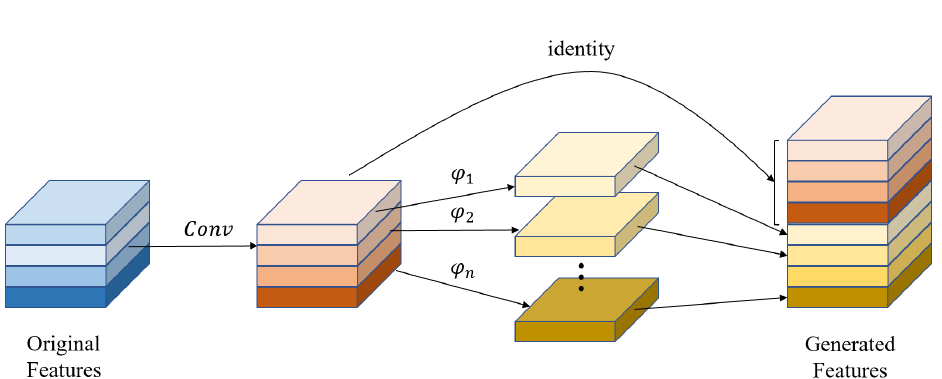
Figure 6. The ghost extension block